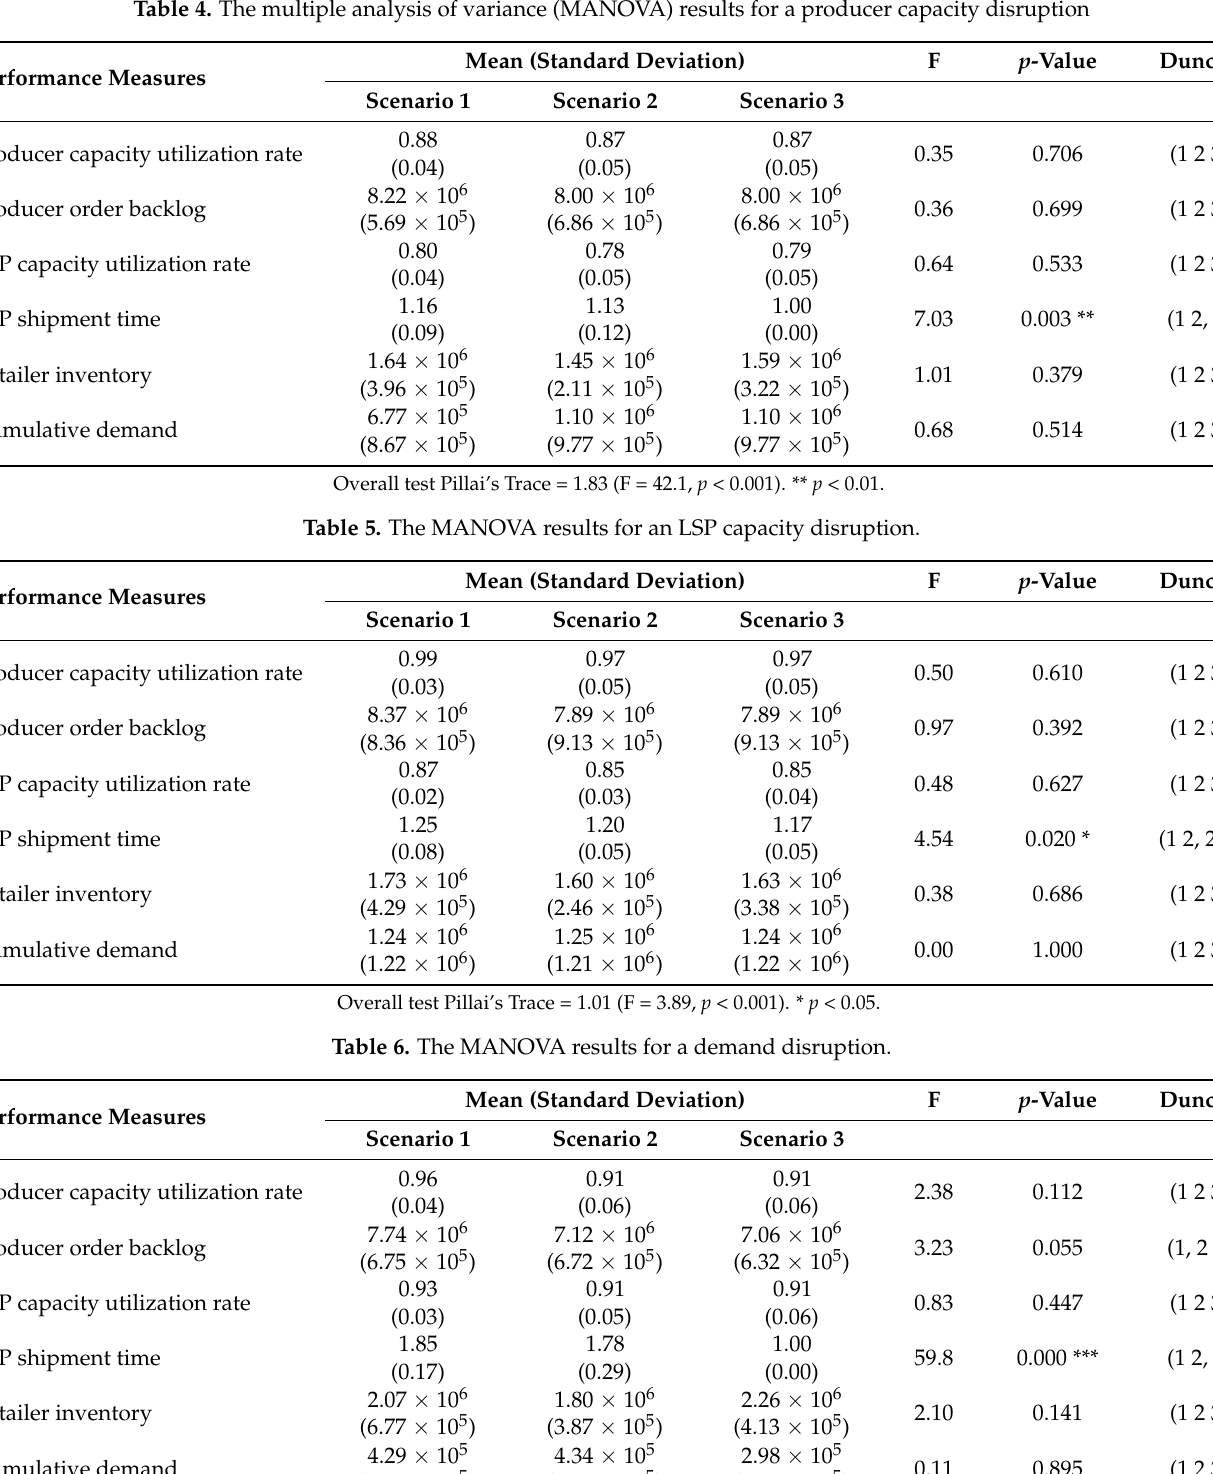
Table 4. The multiple analysis of variance (MANOVA) results for a producer capacity disruption